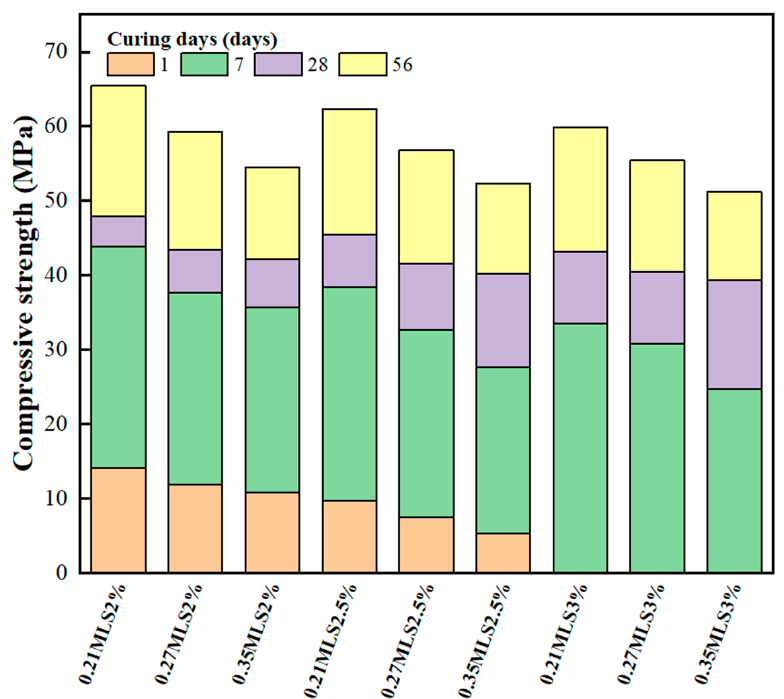
Figure 9. Compressive strength of green and ecofriendly grouting material with MLS.